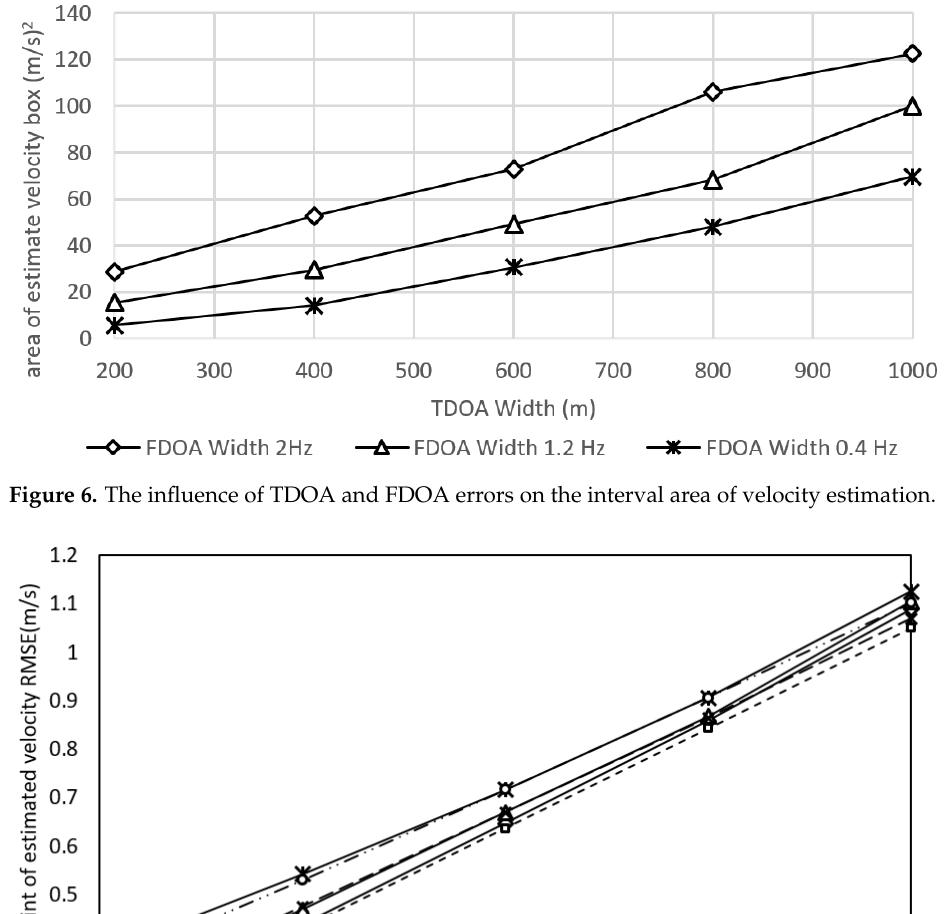
Figure 6. The influence of TDOA and FDOA errors on the interval area of velocity estimation.